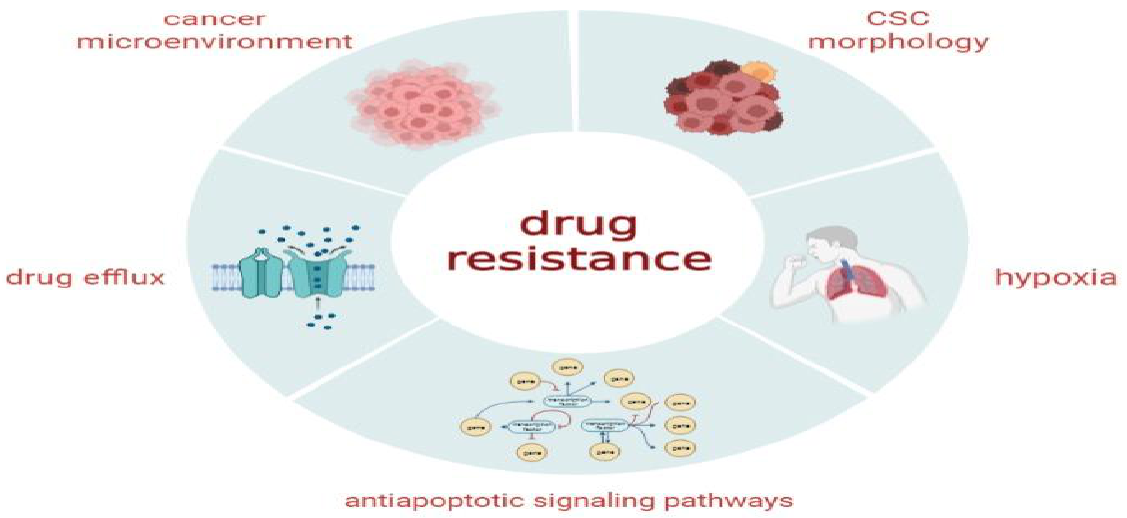
Figure 4. Potential molecular mechanisms that contribute to intrinsic or acquired treatment resistance to conventional therapeutic approaches for various forms of cancer.